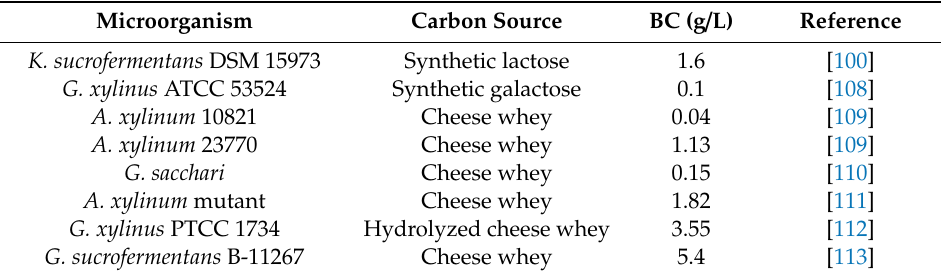
Table 2. Bacterial cellulose (BC) production using lactose or lactose